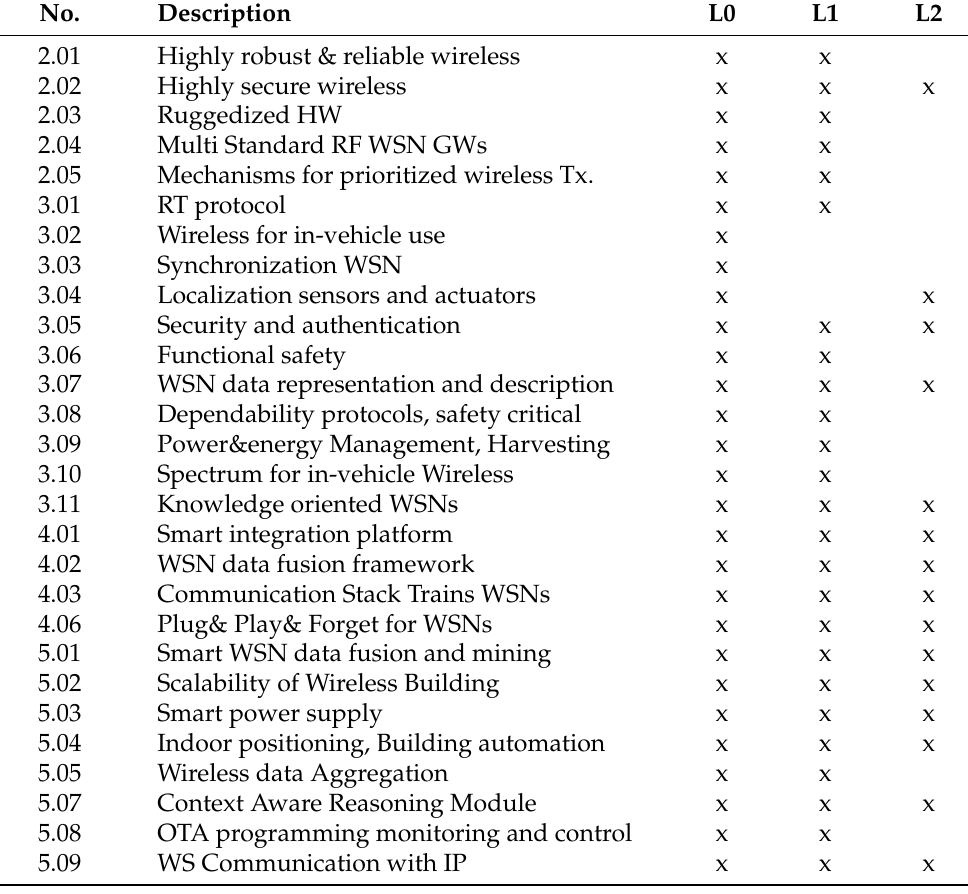
Table 10. Mapping technology items to the DEWI